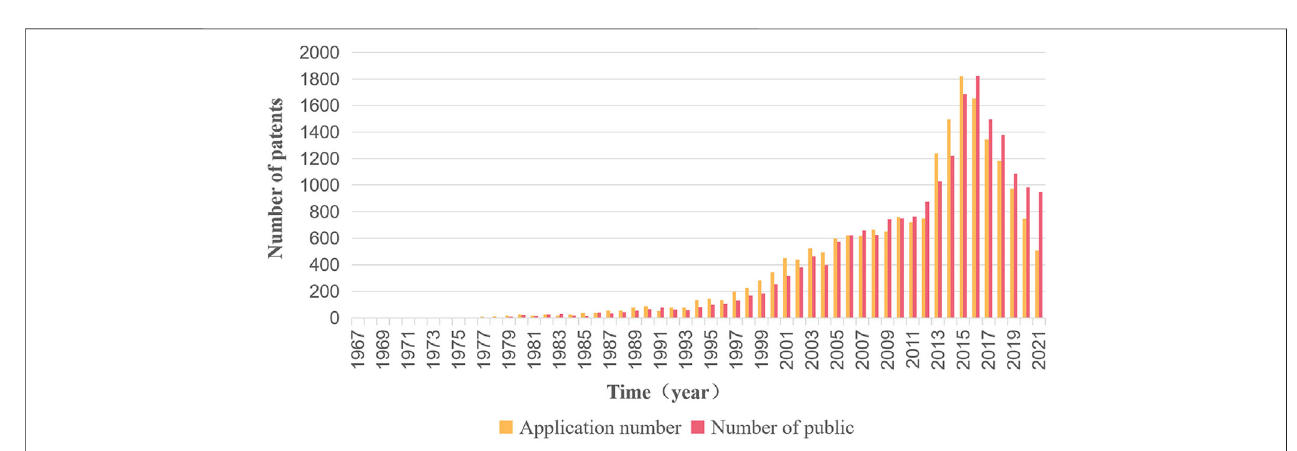
FIGURE 2 | Patent application trends of anticancer natural products. The number of patent applications peaked in 2015.